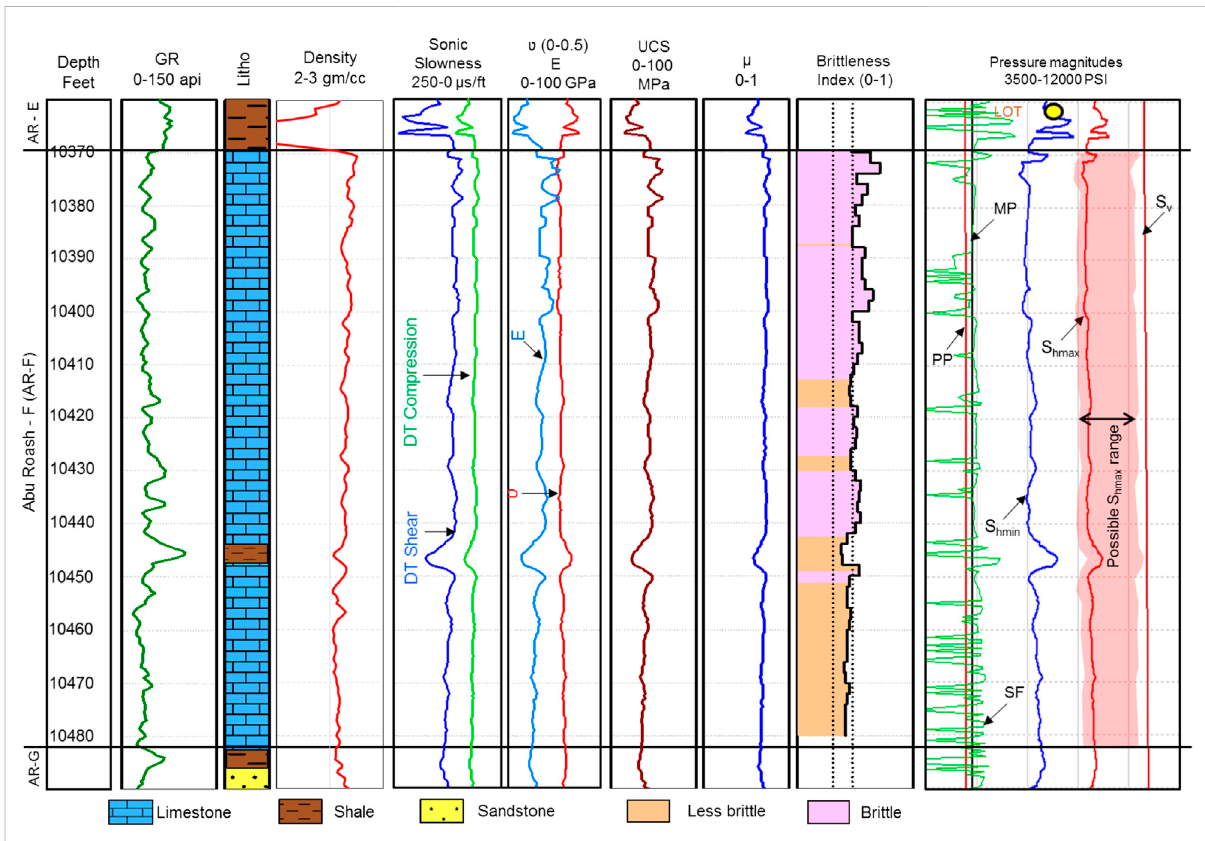
FIGURE 3 Well log-based rock-mechanical properties (E, ʋ , UCS, and µ), brittleness index, pore pressure (PP), shear failure pressure (SF) and in situ stress magnitudes (S v , S hmin , and S hmax ) of the studied AR-F interval. LOT, Leak-off test; PP, formation pore pressure; MP, drilling mud